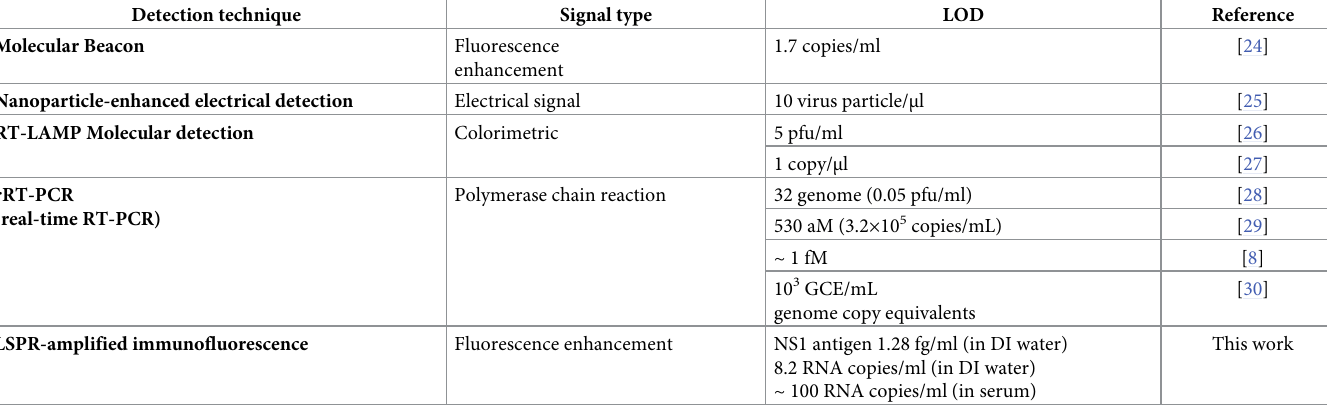
Table 2. Comparison of detection methods in terms of ZIKV detection. Detection